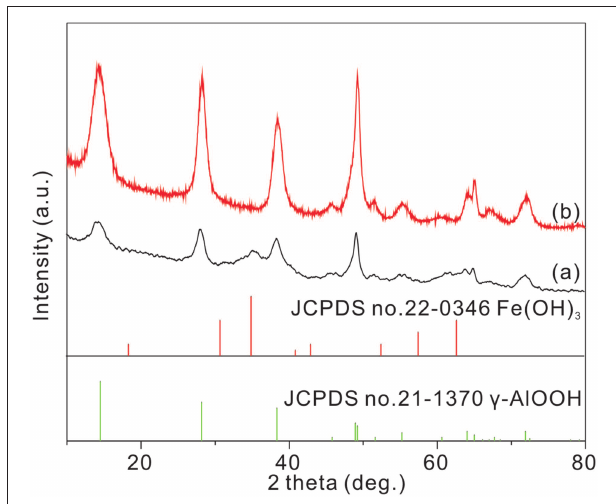
FIGURE 1 | XRD patterns of (a) γ -AlOOH/Fe(OH) 3 and (b) γ -AlOOH